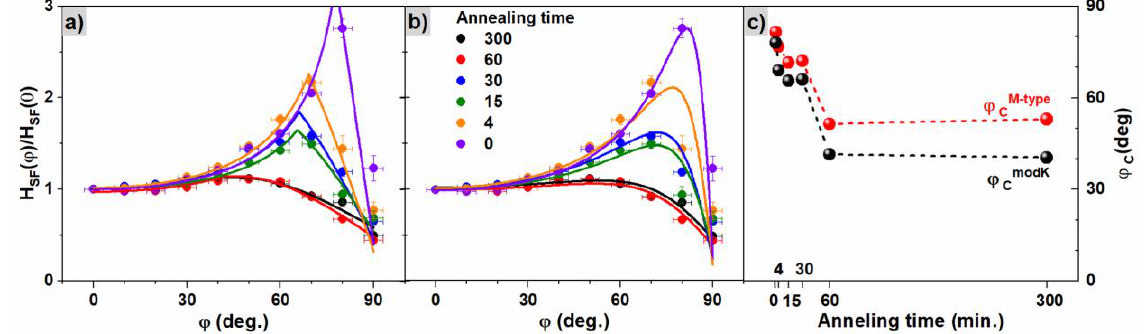
Figure 7. Angular dependence of switching field for samples annealed for different times with solid lines corresponding to fitted functions of ( a ) the modified Kondorsky model and ( b ) the M-type model of the multidomain ferromagnet. ( c ) Critical angle of reversal magnetization mechanism 𝜑 𝐶𝑀−𝑡𝑦𝑝𝑒 and 𝜑 𝐶𝑚𝑜𝑑𝐾 .